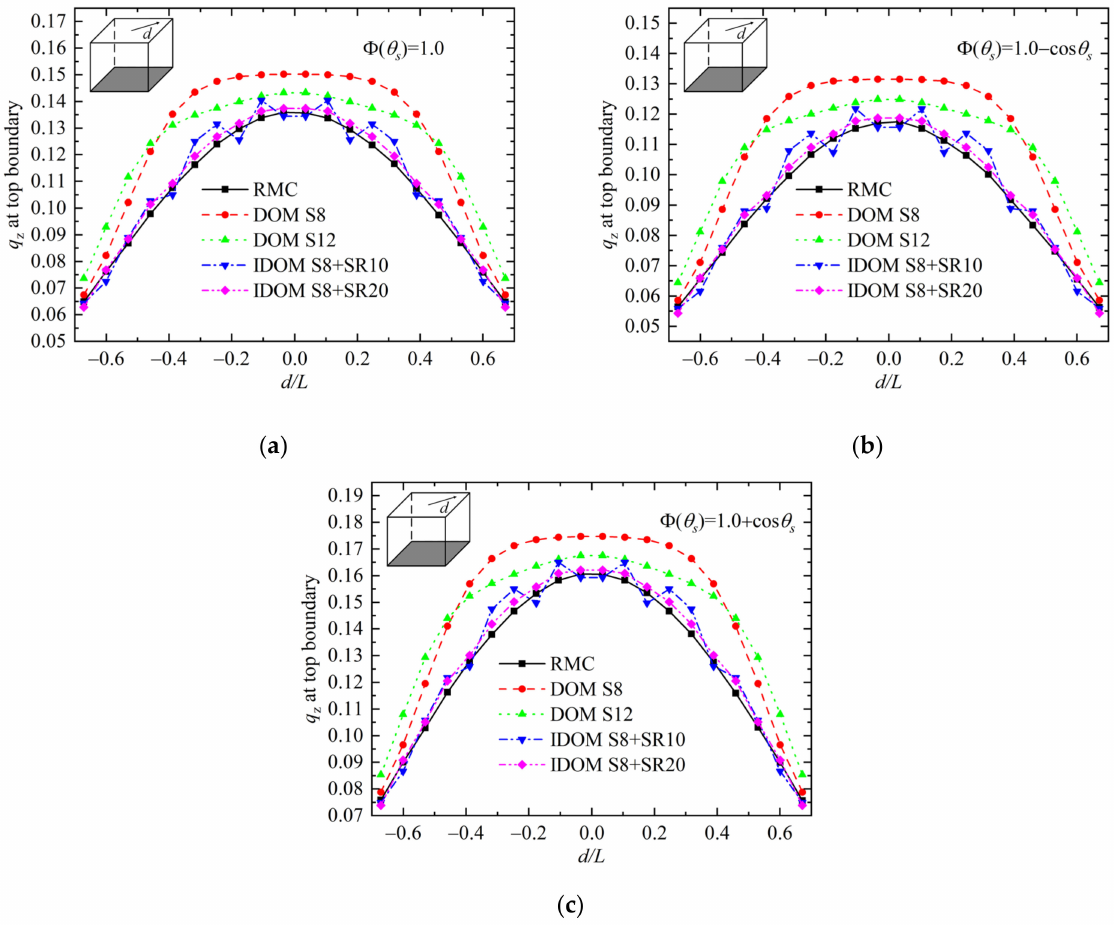
Figure 3. Heat flux at the boundary of Case 1: ( a ) results for A 1 = 0; ( b ) results for A 1 = − 1; ( c ) results for A 1 =